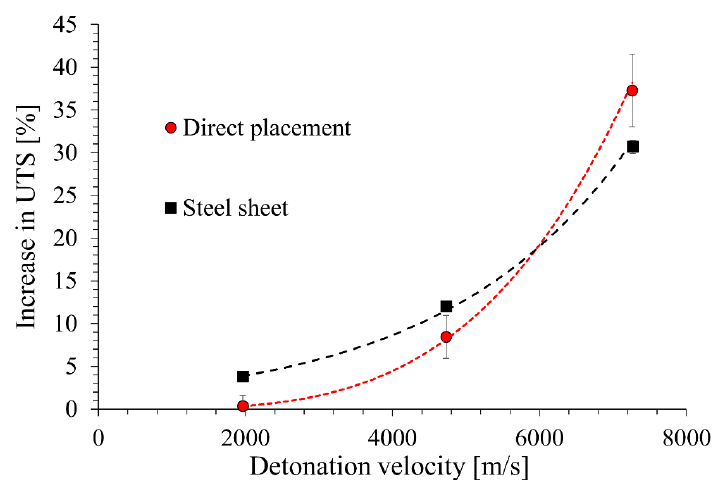
Figure 5. Increase in tensile strength depending on the speed of detonation of the explosive and the method of placing it on the processed plate: directly (direct placement) and through an indirect steel sheet.